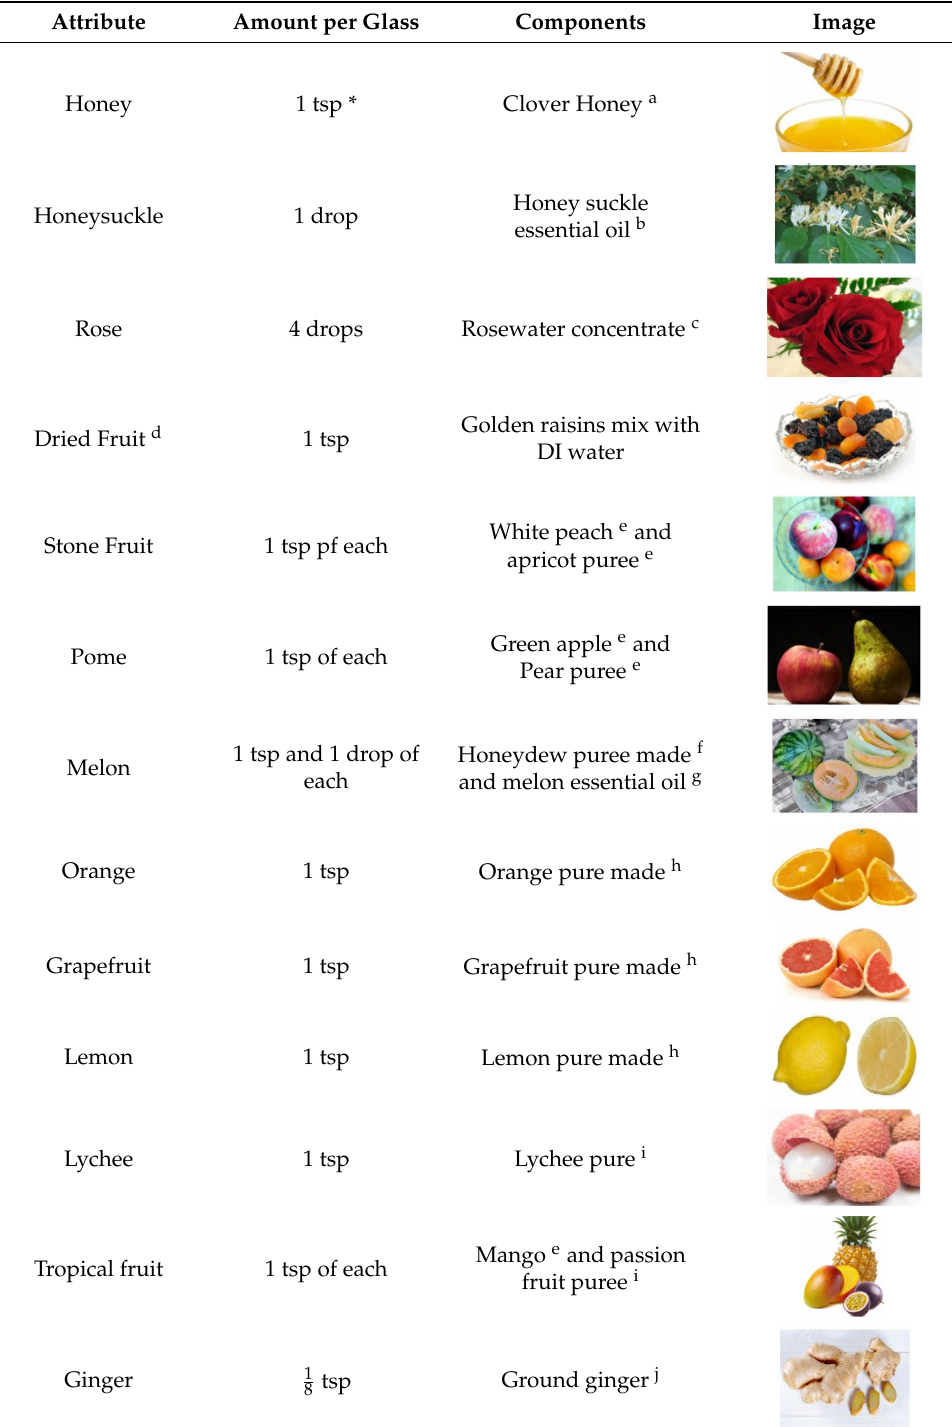
Table 2. Standards and Images used for Descriptive Panel